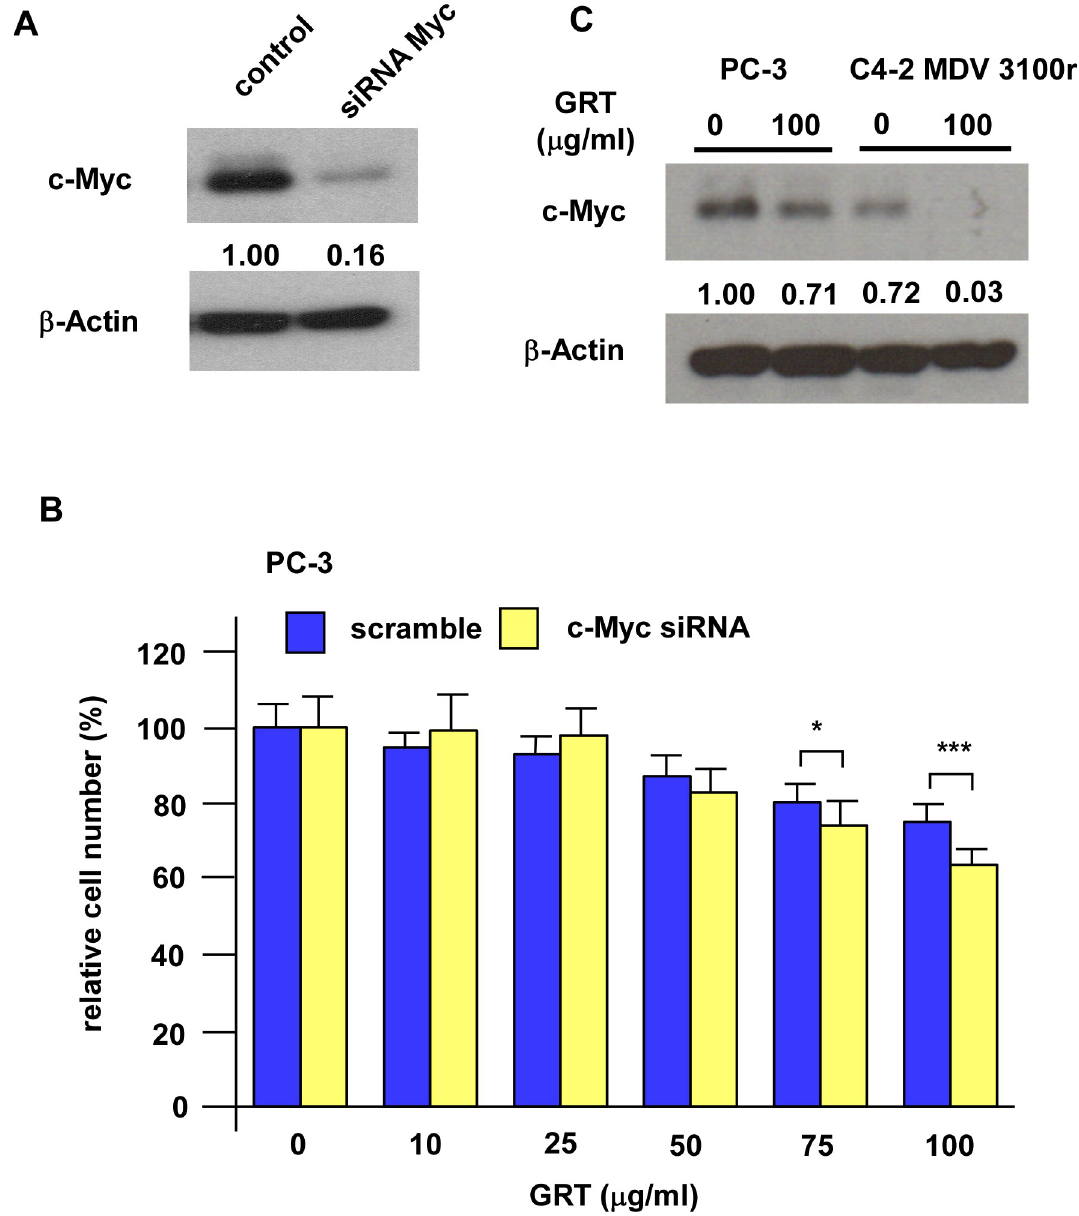
Fig 6. Knockdown of c-Myc increased sensitivity of PC-3 cells to GRT treatment. (A) Knockdown of c-Myc in PC-3 cells was confirmed by Western blotting. (B) PC-3 cells with control scramble or c-Myc knockdown were treated with increasing concentration of GRT (0, 10, 25, 50, 75, 100 μ g/ml) and cell proliferation was examined by proliferation assay. Asterisk � and ��� represents statistically significant difference p < 0.05 and p < 0.001, respectively, between the group as compared to control group or the denoted two groups being compared. (C) The protein expression of c-Myc in C4-2 MDV3100r or PC-3 cells being treated with or without 100 μ g/ml was examined by Western blotting. The β -Actin was used as loading control. overexpression, AR mutation, altered steroidogenesis, AR splice variants, autophagy mediated resistance, and activation of Wnt signaling [14]. New therapy for enzalutamide-resistant PCa is undoubtedly needed. In this study, we examined the suppressive effects of GRT, an aspa- lathin-rich green rooibos extract containing 12.78% aspalathin as major flavonoid, on